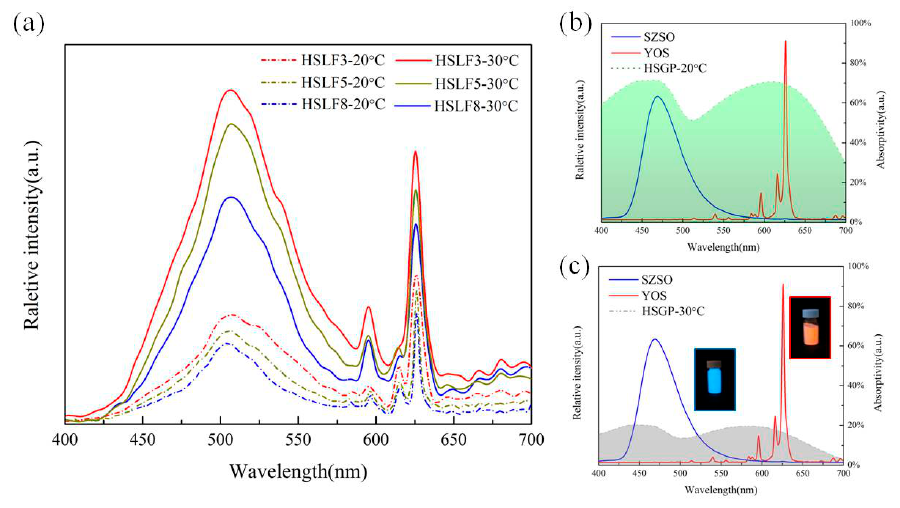
Figure 6. ( a ) Emission spectra of HSLFs at 20 °C and 30 °C. Emission spectra of YOS and SZSO, and the absorption spectra of HSGP, at ( b ) 20 °C and ( c ) 30 °C. Table 1. Integral area of emission spectra.